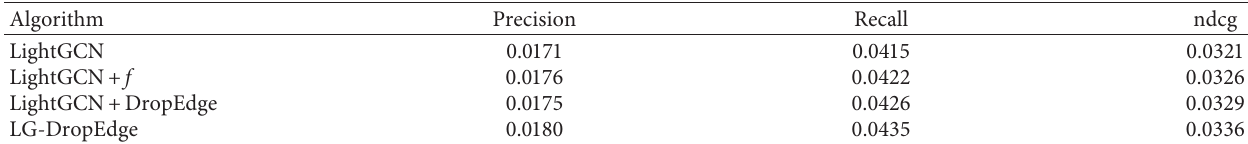
Table 6: Performance of the Amazon-book dataset under the four algorithms.